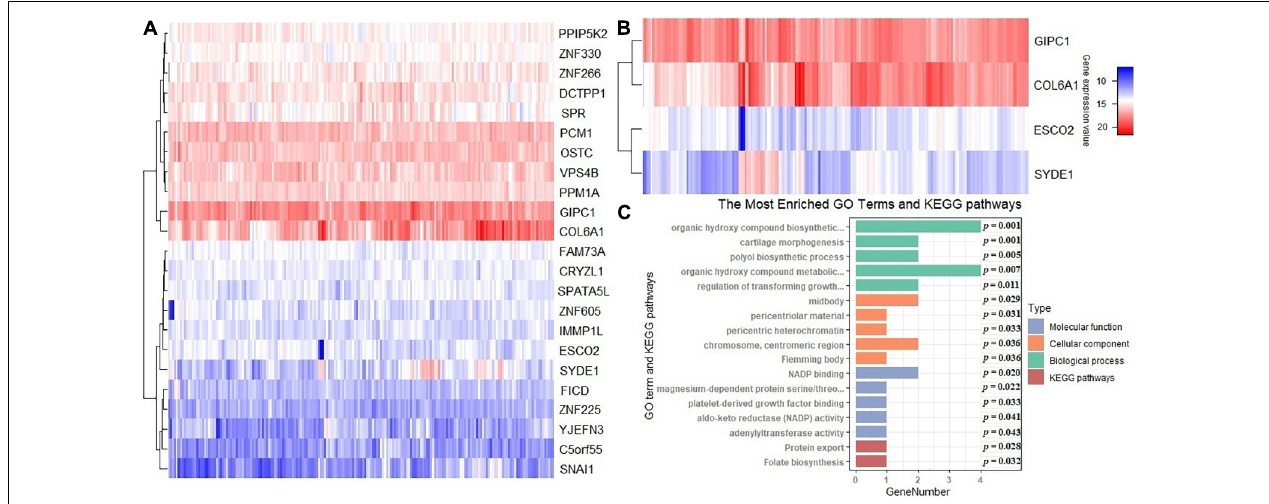
FIGURE 6 | (A) Heatmap of expression levels for these 23 newly identified causal genes of cervical cancer. (B) Heatmap for differentially expressed genes. (C) Gene ontology (GO) and Kyoto Encyclopedia of Genes and Genomes (KEGG) pathway enrichment analyses for the 23 genes; the p -values are also shown. Count Number denotes the number of genes related to the enriched GO or KEGG pathway.